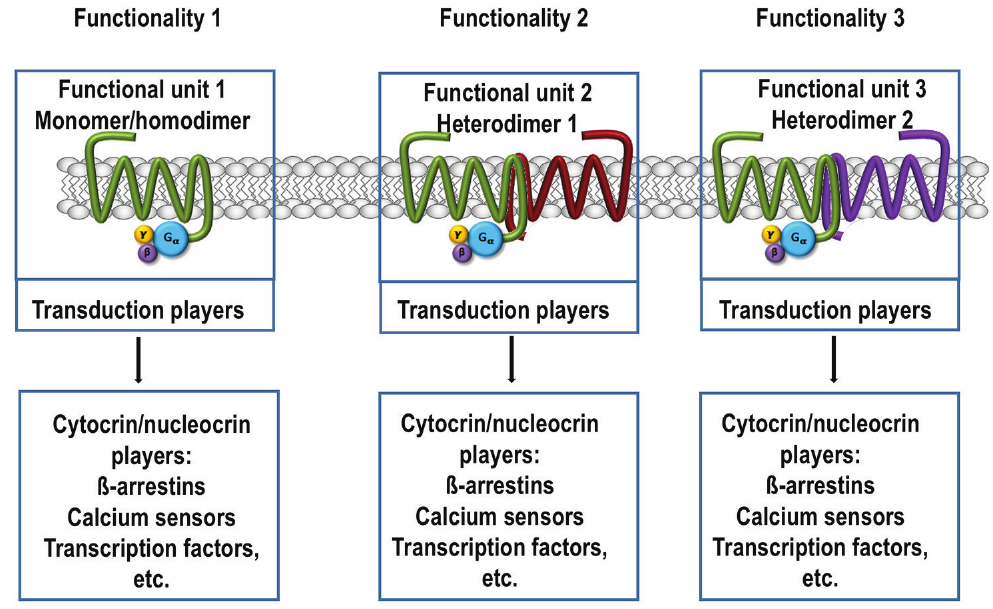
Figure 3: Scheme of biased receptor functionality. A same receptor (in green) in three different heteromeric contexts in a given system may lead to different signaling events using the same agonist. By definition (34), the function of a given heteromer is different of that displayed by the constituting receptors when expressed alone (i.e. in monomeric form). Different heteromeric contexts correlate with different conformations and may occur even in the same system (a given cell). Conformation of the green receptor depends on interactions with other receptors but also on membrane lipid composition, adapter proteins and cellular transmembrane environment. Proteins that interact with the GPCR once it is in active form are considered members of the cytocrin